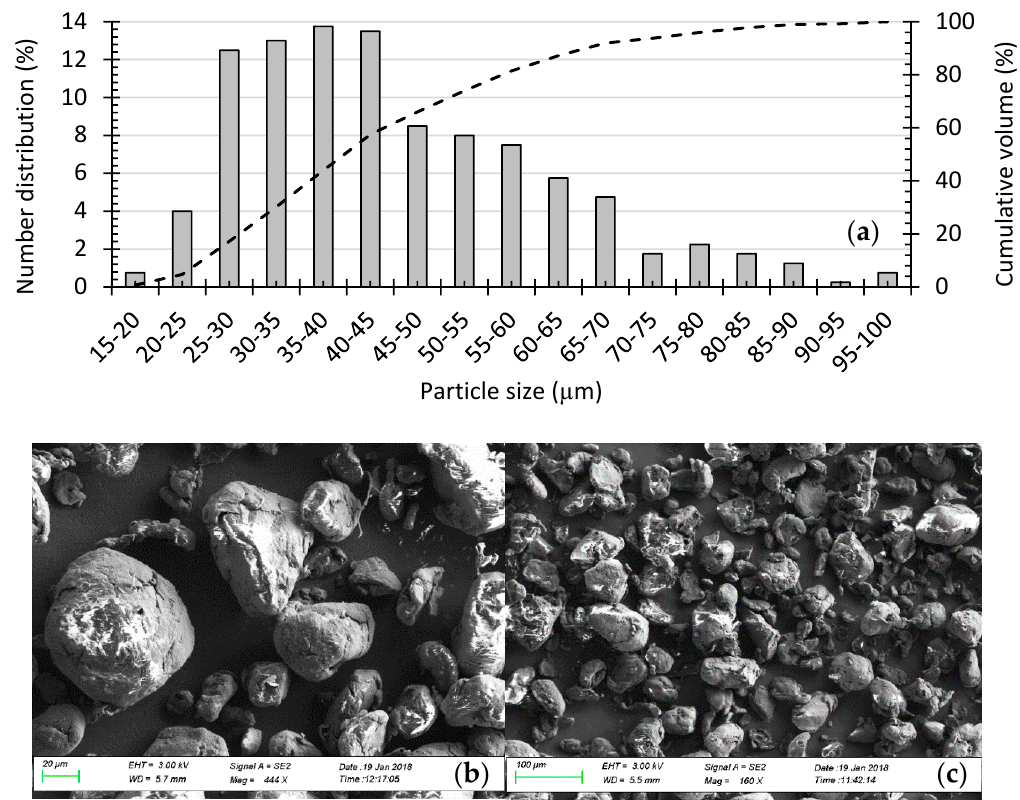
Figure 2. Powder morphology and extrinsic properties. ( a ) Particle-size distribution of coathylene polypropylene; ( b ) A SEM picture with a magnitude of 444× and 20 μ m scale and ( c ) SEM picture with a magnitude of 160× and 100 μ m scale.